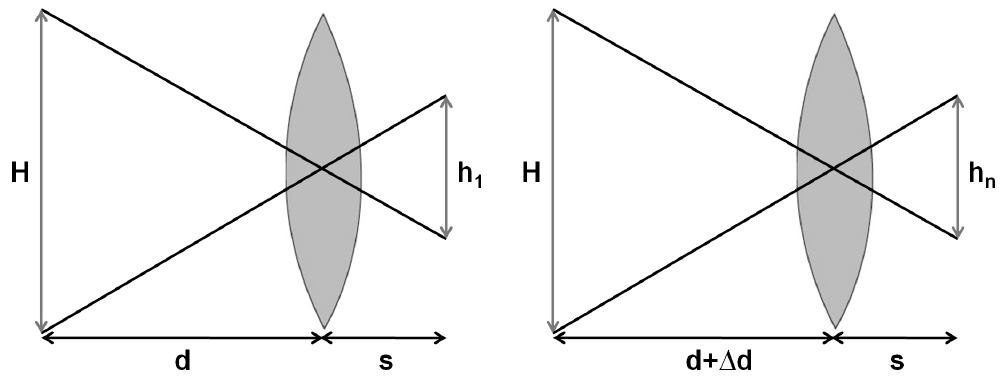
Figure 4. Optical scheme for the 1st and the nth